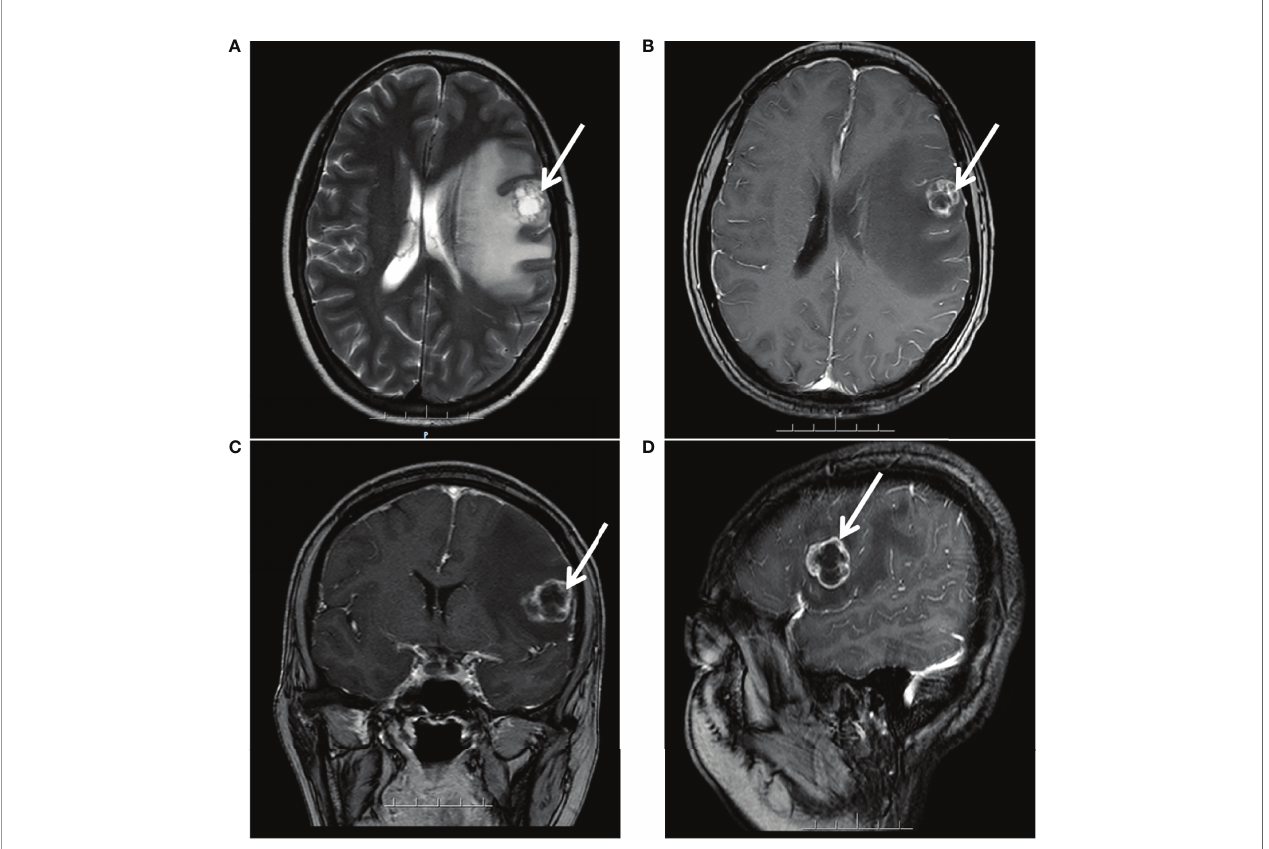
FIGURE 2 | MRI after 21 months of platinum-based chemotherapy: a large prominent tumor in the left frontal lobe with inhomogeneous signal surrounding the tumor mass representing edema. (A) Axial T2-weighted. (B) Axial gadolinium-enhanced T1-weighted FFE. (C) Coronal gadolinium-enhanced T1-weighted FFE. (D) Sagittal gadolinium-enhanced